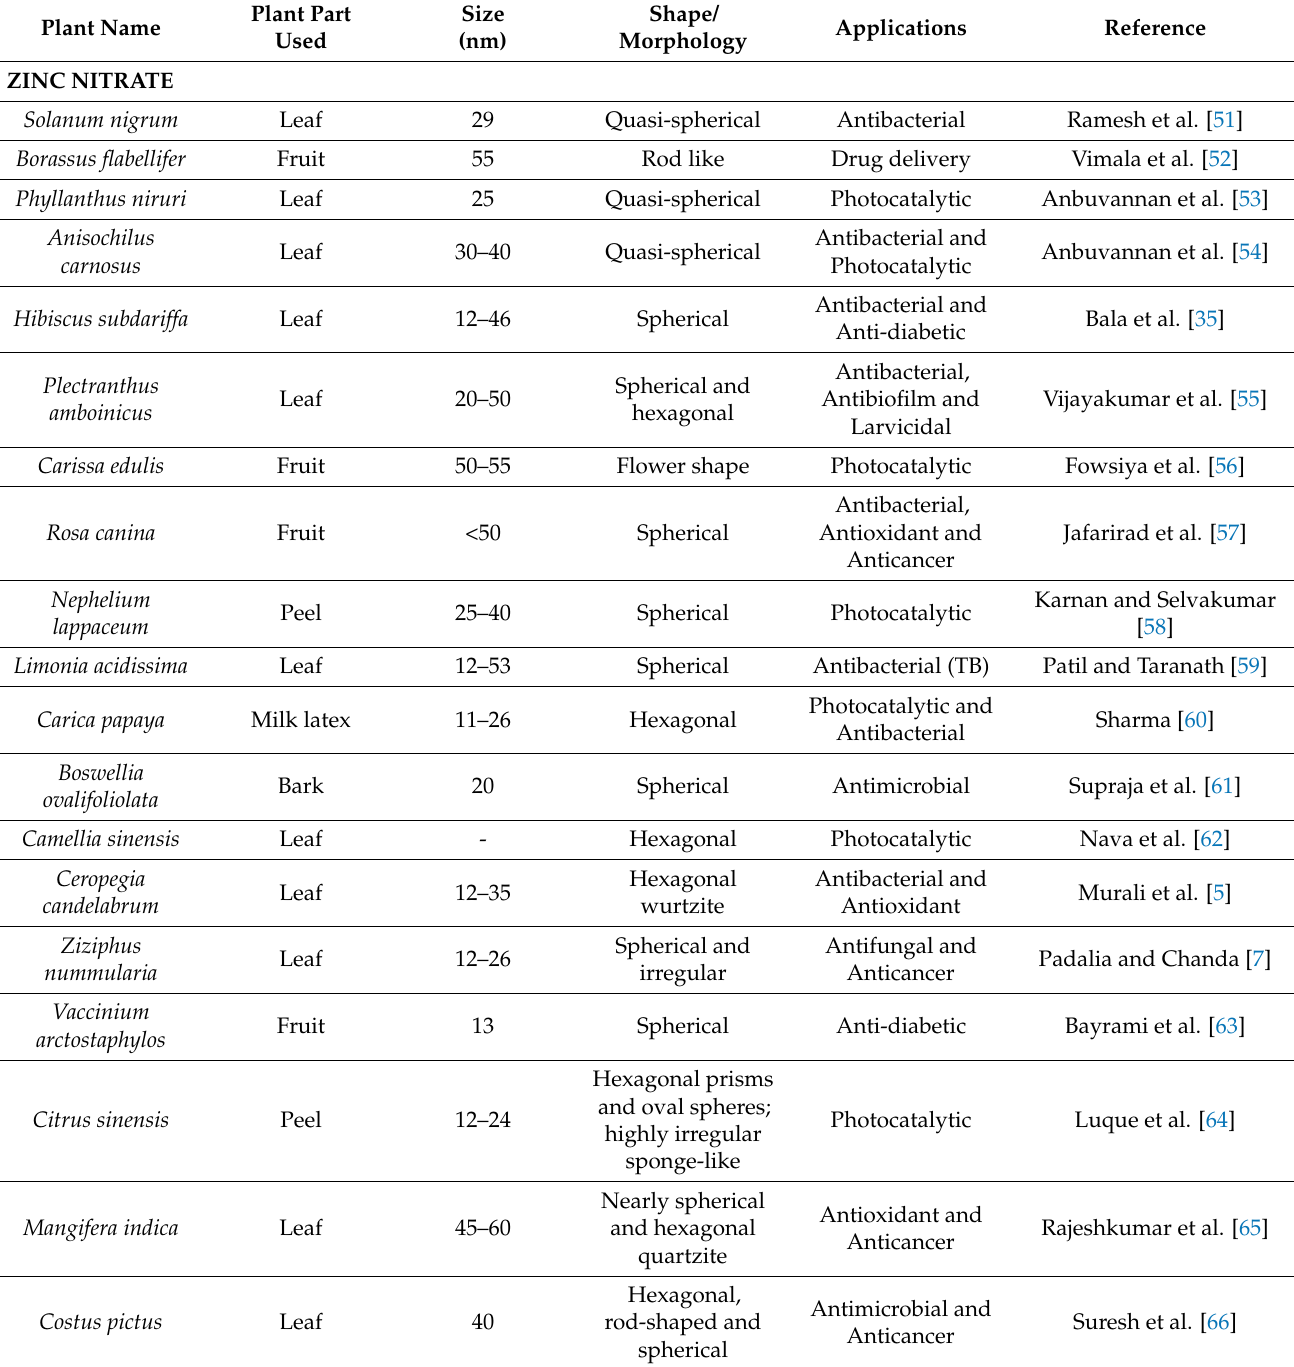
Table 1. Morphology of plant-mediated zinc oxide nanoparticles and their